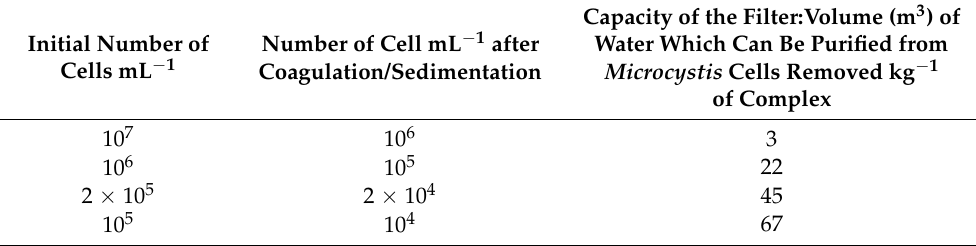
Table 9. Calculated capacities for removal of Microcystis cells by coagulation/sedimentation followed by filtration, assuming that the final numbers of cells in the treated water is limited by 5 × 10 3 cells mL − 1 . Capacity of the Filter:Volume (m 3 ) of Initial Number of Number of Cell mL − 1 after Water Which Can Be Purified from Cells mL − 1 Microcystis Cells Removed kg − 1 Coagulation/Sedimentation of